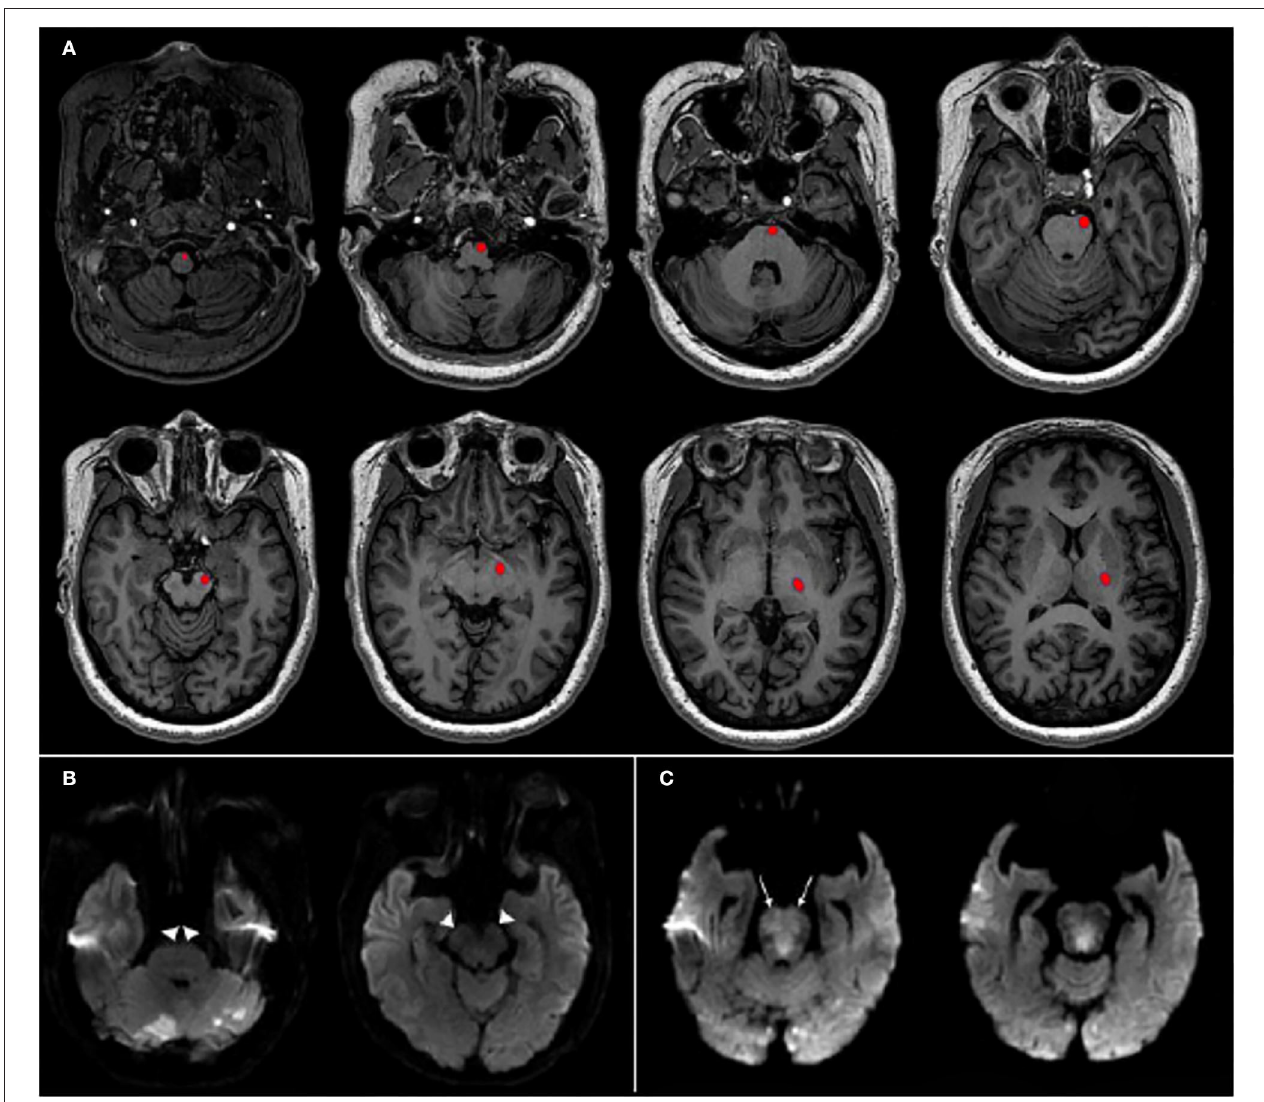
FIGURE 2 | Templates of corticospinal tract (CST) and illustrative cases. (A) The pathways of CST from supratentorial to brainstem structures are shown in red at each level of the template maps. (B) A 69-y-old man who had a baseline National Institutes of Health Stroke Scale (NIHSS) score of 17 and distal basilar artery occlusion was treated by endovascular treatment (EVT). Time from symptom onset to groin puncture was 132min and complete recanalization was obtained. Follow-up diffusion-weighted imaging after EVT revealed CST salvage (arrow heads). Final infarct volume was 24.3mL and his 3-mo modified Rankin Scale (mRS) score was 2. (C) A 82-y-old woman who had a baseline NIHSS score of 27 and proximal to mid-basilar artery occlusion with onset-to-groin puncture time of 284min was fully recanalized by EVT. Final infarct volume was 4.8mL. However, follow-up diffusion-weighted imaging showed CST involvement on bilateral upper pons (arrows) and her 3-mo mRS score was